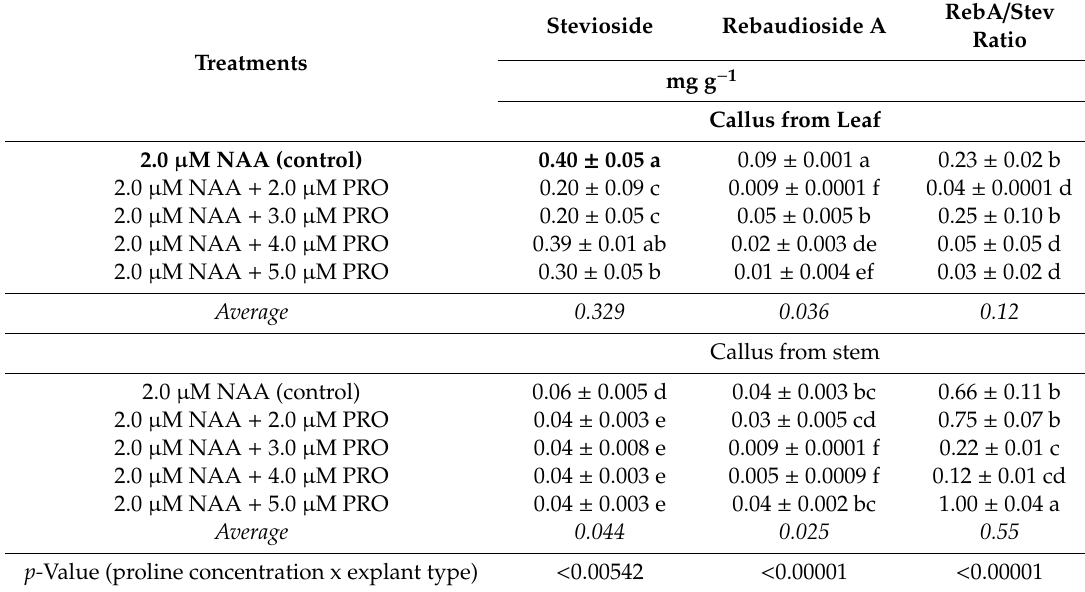
Table 3. E ff ect of NAA and PRO on accumulation of steviol glycosides and ratio of rebaudioside A / stevioside (RebA / Stev) in callus culture from leaf and stem explants. Mean value ± standard error, n =